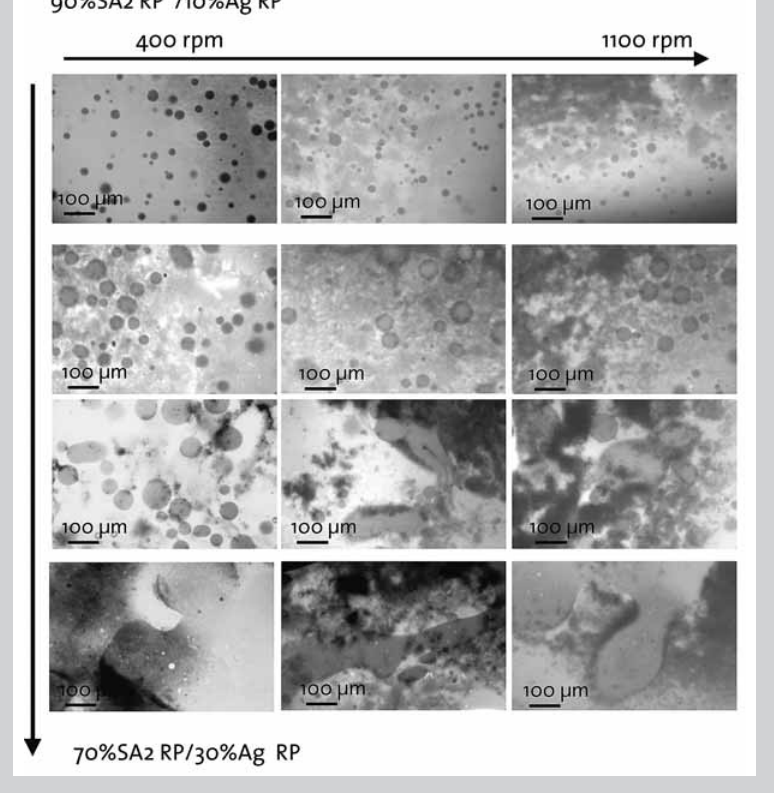
Figure 13: Effect of phase volume and mixing speed on the micro- structure of maltodextrin/ agarose gel composites. The composites were obtained by mixing in different ratios and speeds, the rich phases from the phase separation of 12.5 % SA2 / 5 % Ag (Con- focal microscope observa-